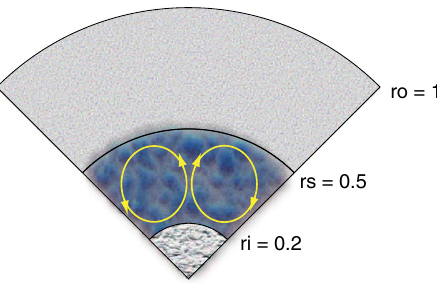
Fig. 1 Model geometry in units of core radius. The radius of the solid inner core is r i = 0.2. The interface of the thermally stably strati fi ed layer is set at r = 0.5. Above r fi ed region extends to the core s s , the thermally stably strati mantle boundary, r o =